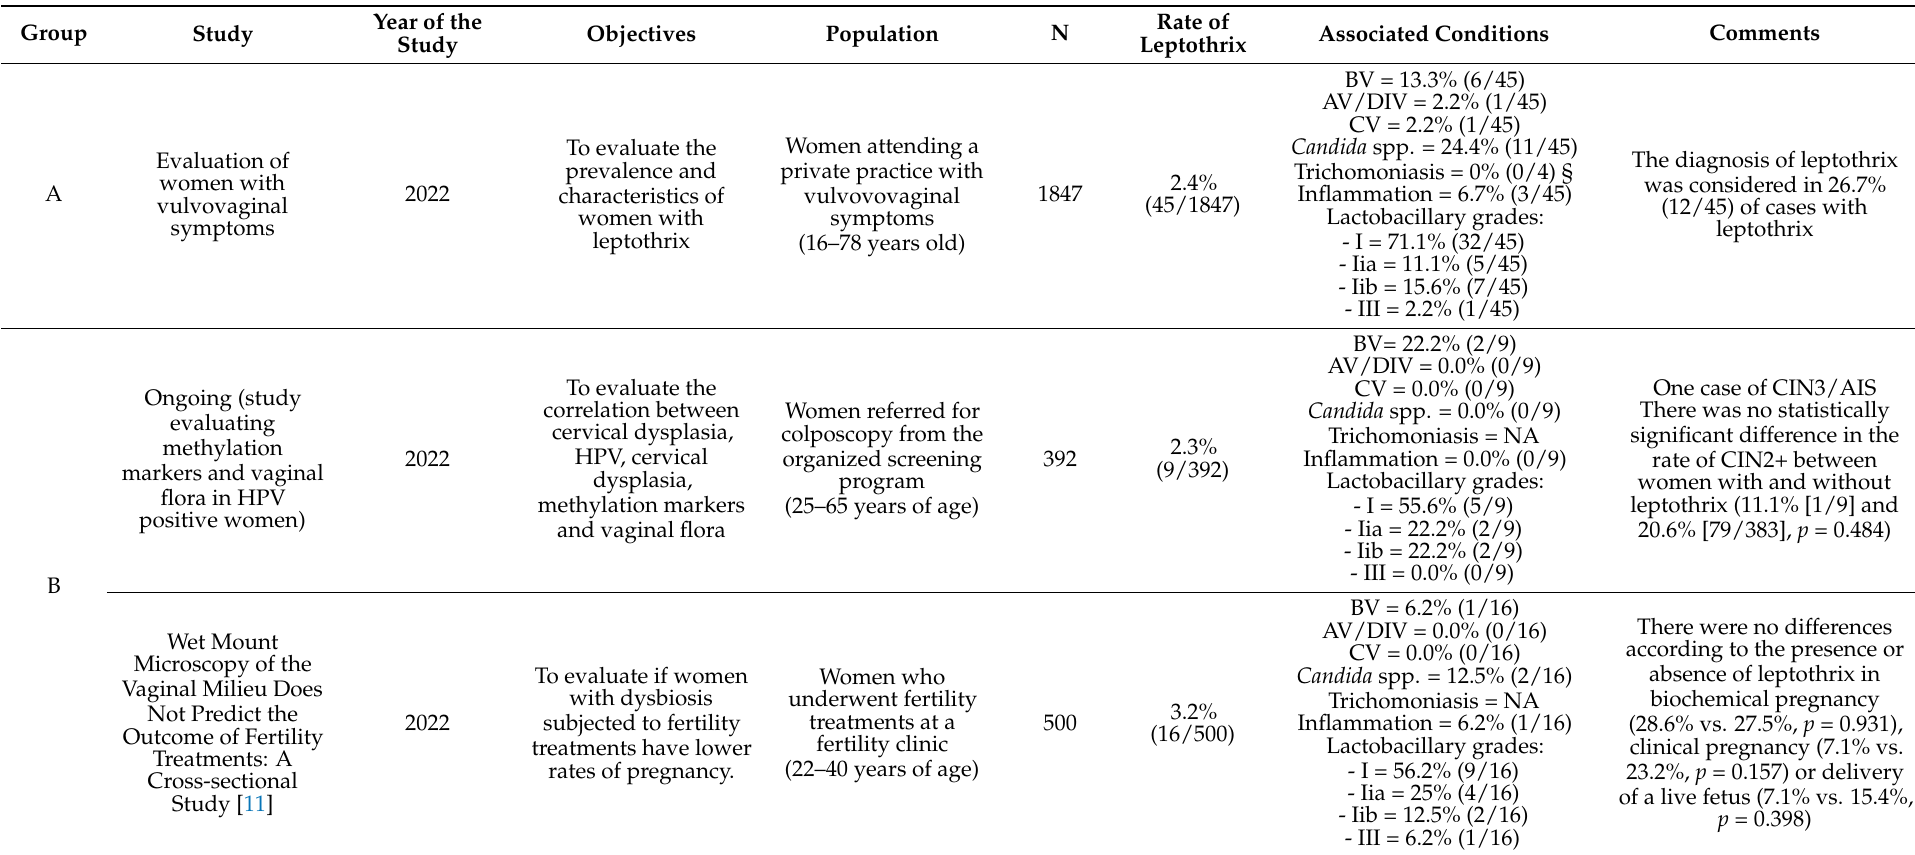
Table 3. Evaluation of previous and ongoing studies by the authors in which wet mount microscopy was performed and data about leptothrix is available on file. The total number of cases may differ from the figures shown in the published studies, as we evaluated all cases available, regardless of inclusion in the final analysis. Inflammation was defined as >10 leukocytes per high power